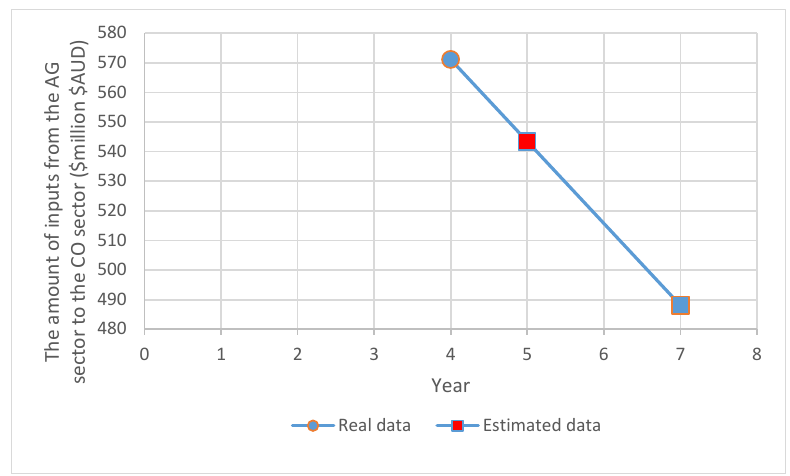
Figure 3. Inputs from the AG sector to the MI sector (quadratic polynomial equation). Agriculture, forestry, and fishing = AG; Mining = MI.